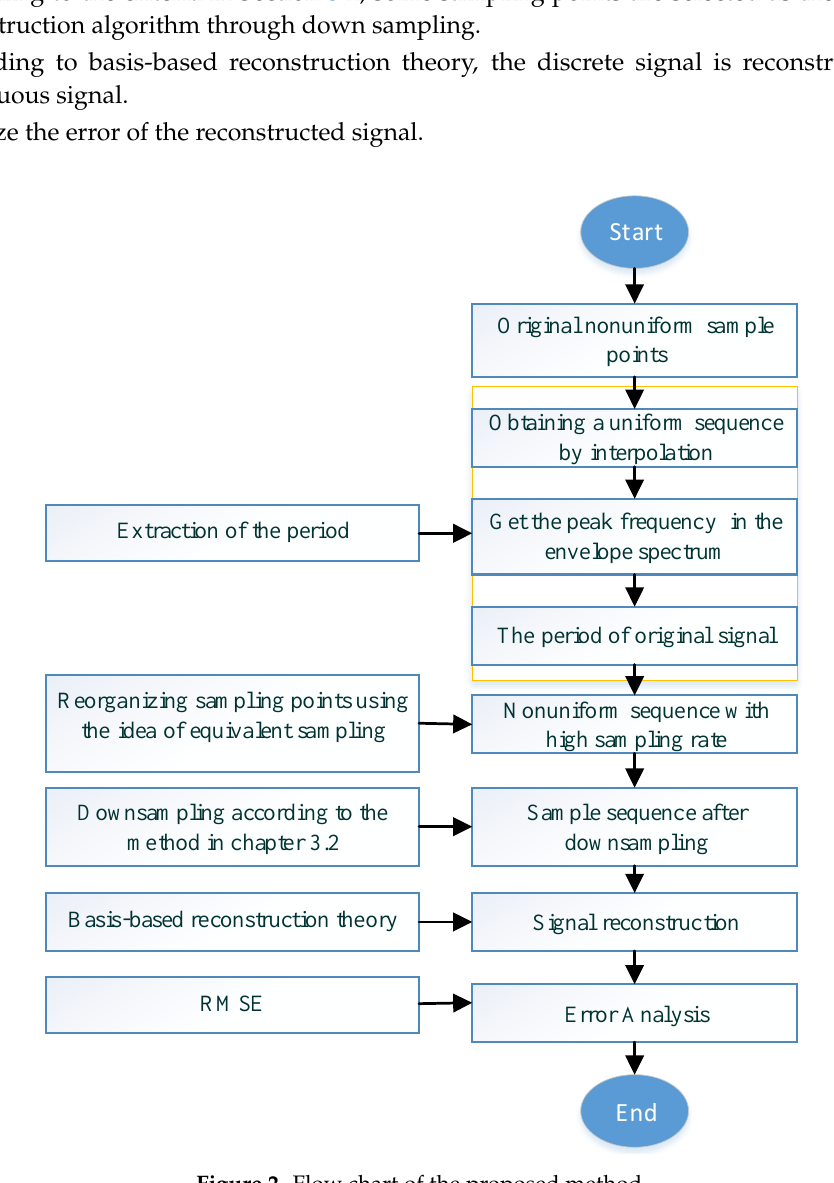
Figure 2. Flow chart of the proposed method.